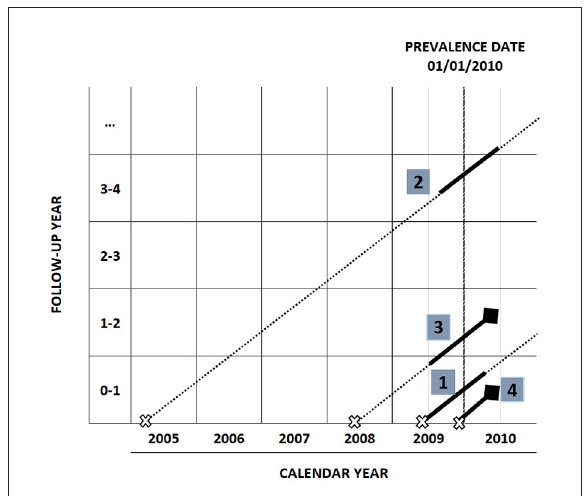
FIGURE1 Phase of care attribution in a cross-sectional study design with prevalence date